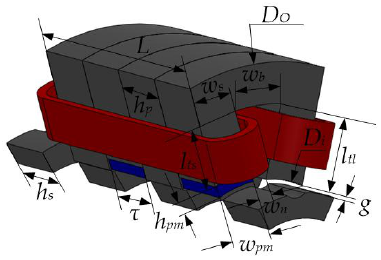
Figure 5. Structure diagram of the unit machine.